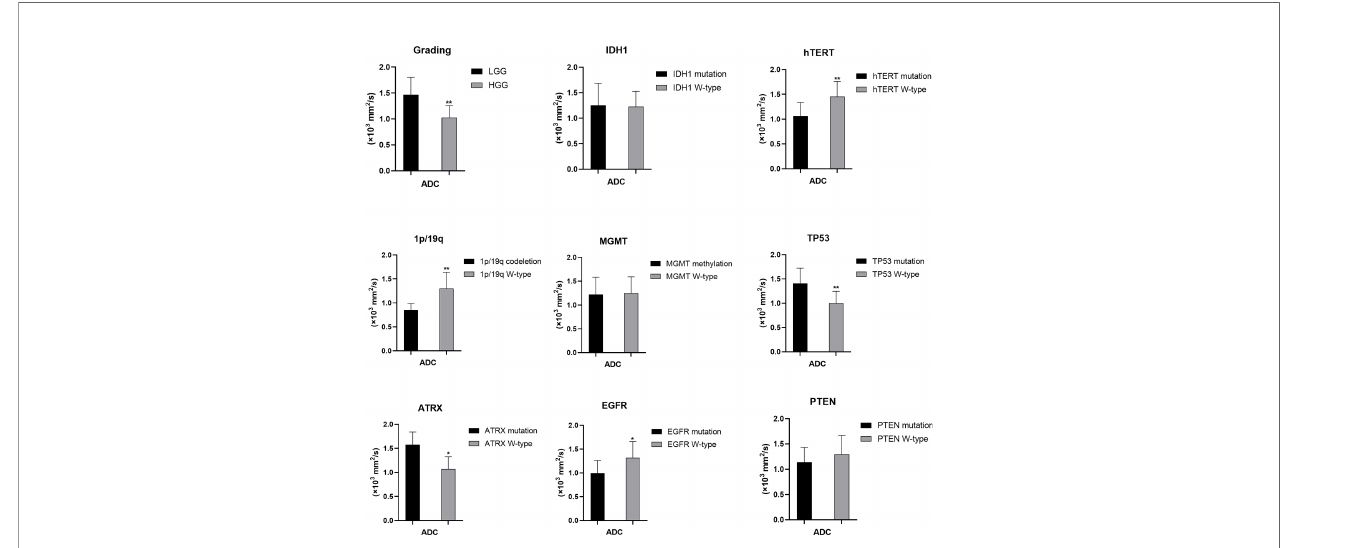
FIGURE 4 | Statistic results of grading, IDH1/2, 1p/19q, MGMT, hTERT, TP53, PTEN, EGFR, ATRX mutations status and ADC (*P < 0.05, **P < 0.01).